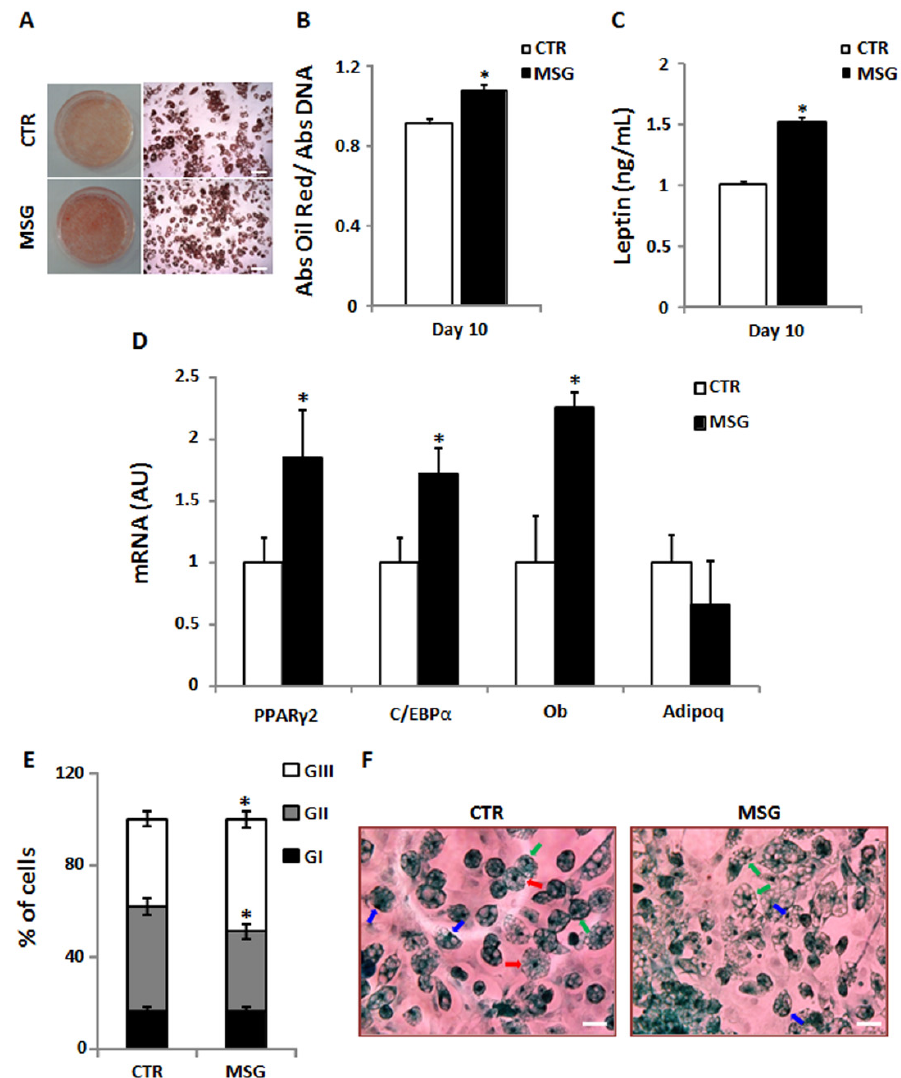
Figure 3. MSG cells exhibit increased in vitro adipocyte differentiation. ( A ) Macroscopic (left panel) and microscopic (right panel, magnification 10×, scale bars at 200 μ m) views of the Oil Red O ‐ stained dishes; ( B ) Quantification of intracellular lipid accumulation; ( C ) cell leptin secretion ( n = 5/6 different experiments with 10/12 wells per day per experiment) and ( D ) cell mRNA expression levels of PPAR ‐γ 2, CCAAT/enhancer binding protein (C/EBP) α , Leptin (Ob) and Adiponectin (Adipoq) on Differentiation day (Dd) 10 of SVF cells isolated from RPAT pads of 30 day ‐ old CTR and MSG male rats ( n = 5/6 different experiments) (AU: arbitrary units); ( E ) Percentages of cells according to their stages of maturation; ( F ) Representative fields containing in vitro differentiated CTR and MSG adipocytes (stained on Dd 10, magnification 40×, scale bars at 20 μ m), displaying different degrees of maturation depending on the nucleus position: GI, central (red arrow); GII, displaced from the center (green arrow); and GIII: fully peripheral (blue arrow) ( n = 4/5 different experiments; data from 200/250 cells were recorded in each experiment). Values are means ± SEM *, p < 0.05 vs. CTR values.